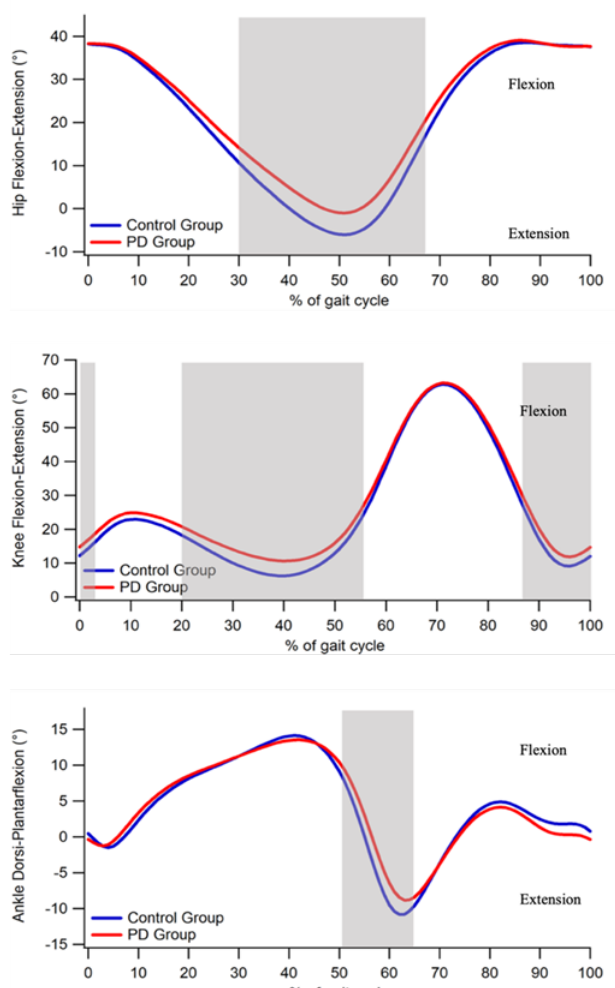
Figure 2. Gait kinematics in the sagittal plane. From top to bottom: hip flexion–extension, knee flexion–extension and ankle dorsi–plantar-flexion angles during gait cycle. Gray-shaded areas denote the periods of the gait cycle in which a significant difference between groups existed ( p < 0.05).